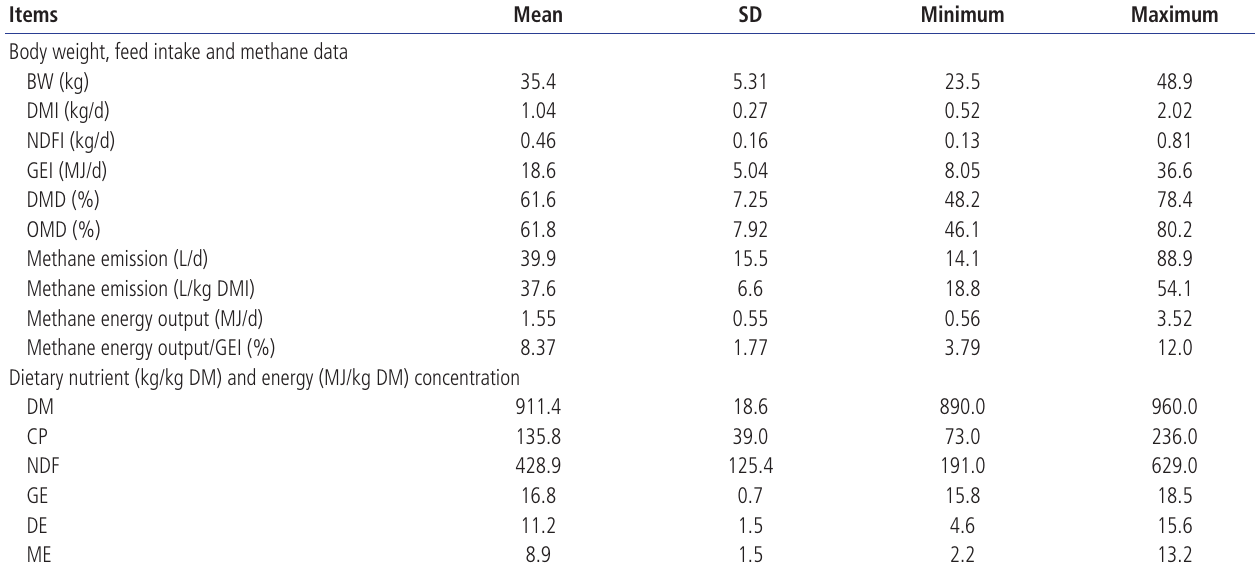
Table 1. Animal and dietary data (n = 159) Items